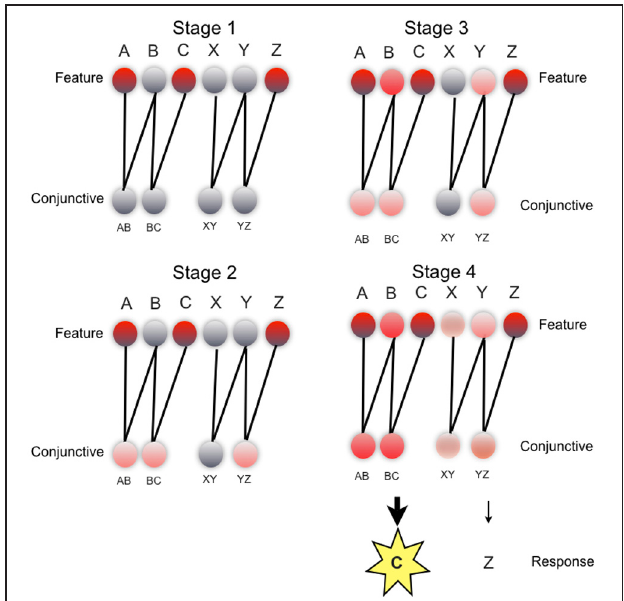
FIGURE 3 | REMERGE model: schematic of evolution of network activity during a ACZ test trial in the paired associate inference task. Each stage illustrates pattern of network activity over feature layer (upper) and conjunctive layer (lower), during key phases of processing (see main text for details). Feature layer units (upper) denote individual objects (i.e., A, B, C, X, Y, Z). Conjunctive layer units (lower) code pairs of objects presented during the study phase of the experiment, in localist fashion (i.e., AB, BC, XY, YZ). Feature layer and conjunctive layer connected by recurrent excitatory connections. Response layer not shown. Unit activity denoted by color: from gray (low activity) to red (high activity). Details of transfer functions and parameters used in the network, and quantitative simulations of empirical data are described elsewhere (Kumaran and McClelland, in